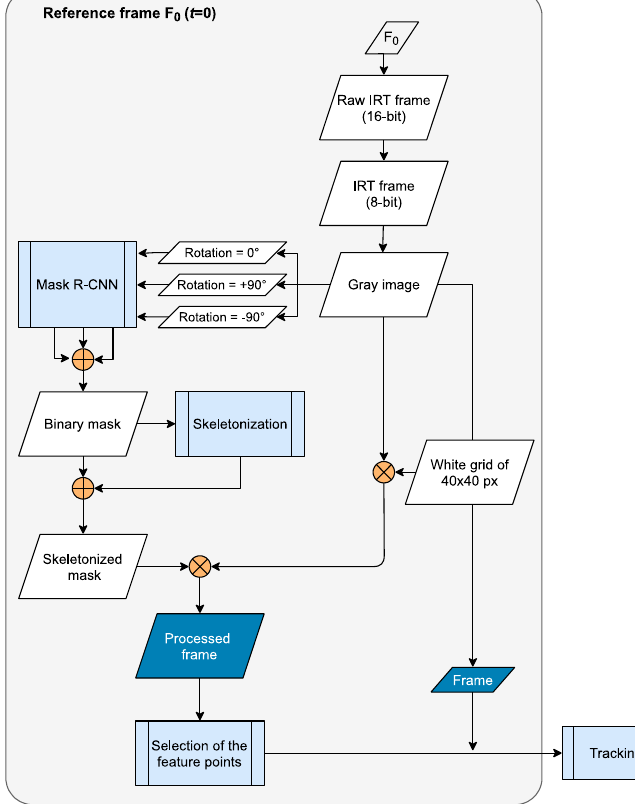
Figure 2. Flowchart of the reference frame’s image processing method for the IRT data. Note there is no equalization process, the white grid applied to the gray image has a size of 40 px, and the different masks obtained from the mask R-CNN are merged (from different rotation angles of the gray image).